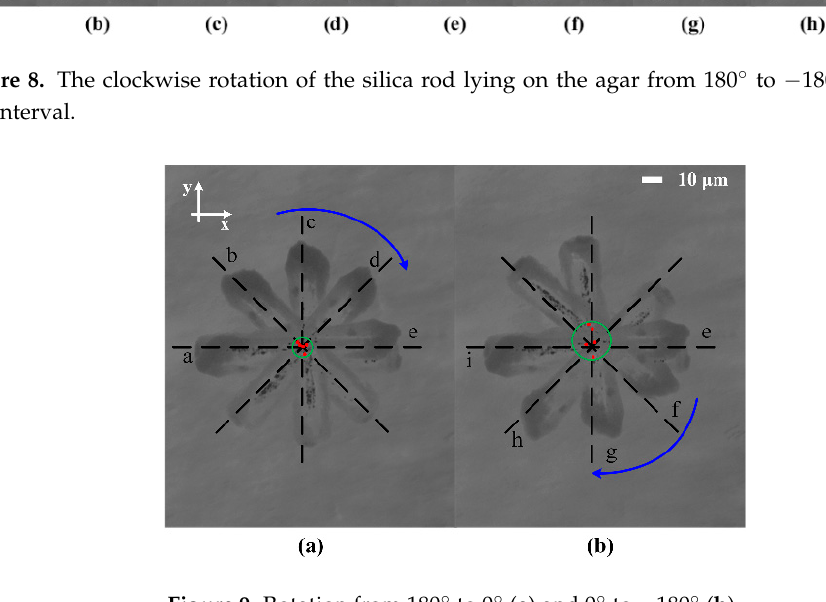
Figure 9. Rotation from 180° to 0° ( a ) and 0° to − 180° ( b ).